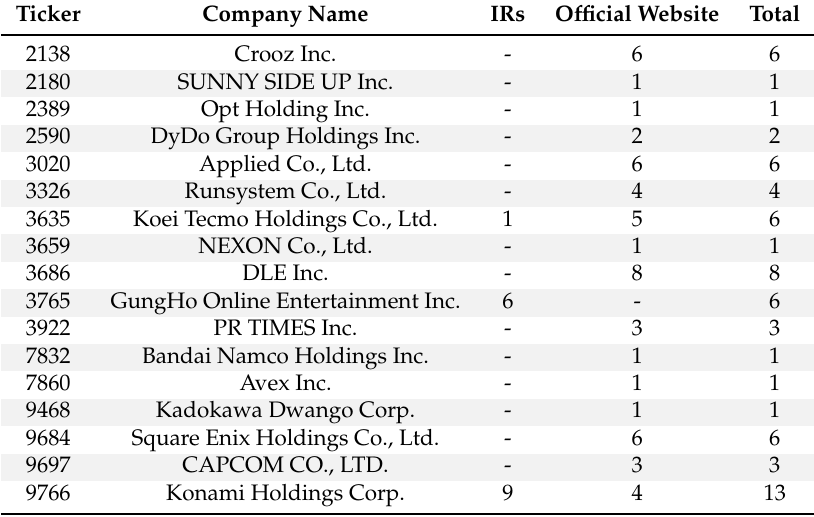
Table 3. Exact matching test for investor relations (IRs) and official websites for “e-Sports”. Numbers mean how many times “e-Sports” appeared in each company’s IRs or official website. Ticker Company Name IRs Official Website Total 2138 Crooz Inc. - 2180 SUNNY SIDE UP Inc. - 1 1 2389 Opt Holding Inc. - 1 1 2590 DyDo Group Holdings Inc. - 2 Applied Co., Ltd. - Runsystem Co., Ltd. NEXON Co., Ltd. - - GungHo Online Entertainment Inc. PR TIMES Inc.